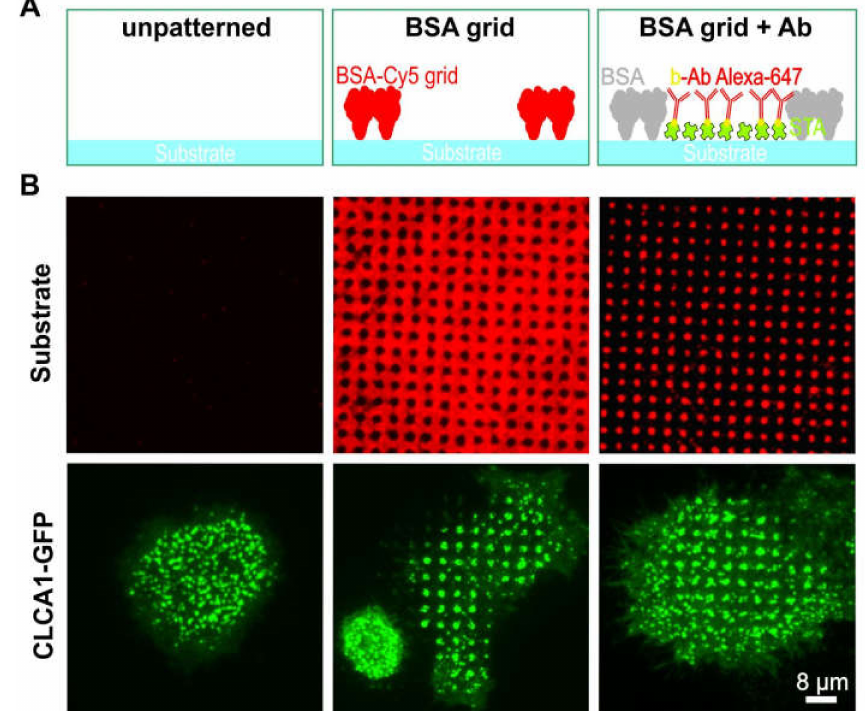
Figure 2. E ff ect of protein patterning on the distribution of clathrin in live cells. ( A ) Schematic illustration of the surface functionalization used in ( B ). ( B ) TIRF microscopy images of HeLa cells transiently expressing CLCA1-GFP. Left panel: plane glass substrate, middle panel: 1 µ m BSA-Cy5 grid not filled with antibody, and right panel: 1 µ m BSA grid filled with Alexa-647 labeled antibody (biotinylated). Abbreviations: b-Ab, biotinylated antibody; BSA, bovine serum albumin; and STA, streptavidin. Schematic illustrations are not drawn to